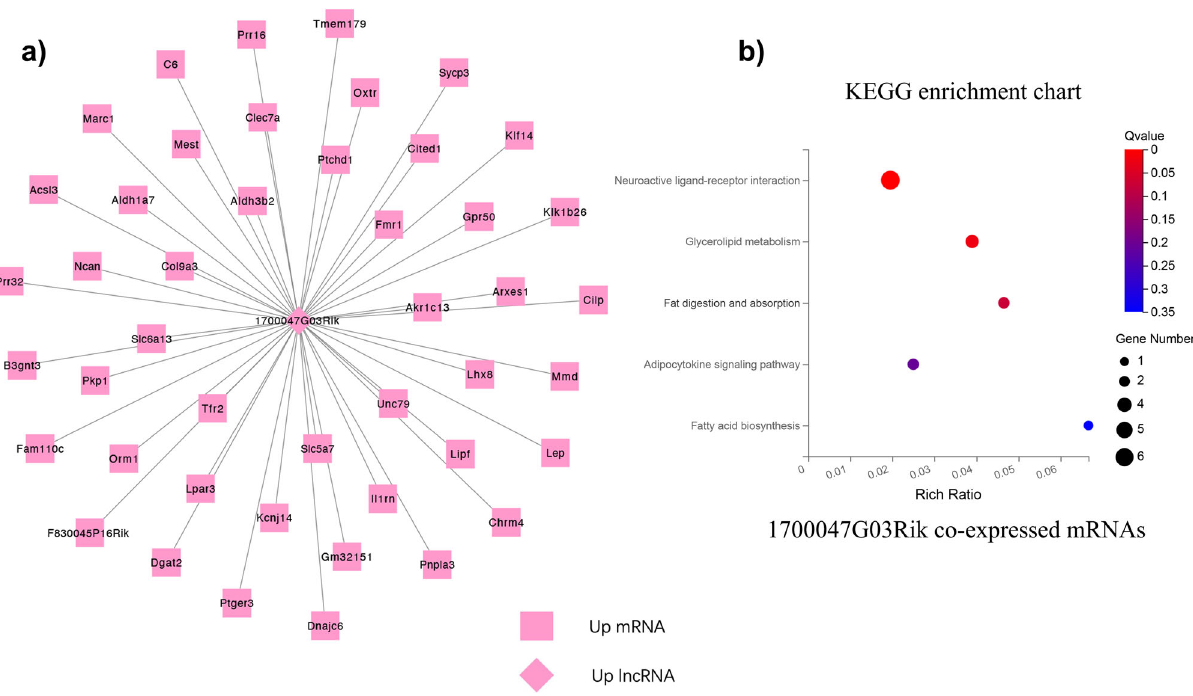
Fig. 8 Co-expression network analysis and functional prediction of lncRNA 1700047G03Rik. a The lncRNA 1700047G03Rik and 45 mRNAs were constructed in a co ‐ expression network with a PCC > 0.95. b The top signi fi cant pathway terms of dysregulated genes associated with 1700047G03Rik were displayed according to KEGG analysis. Note: PCC: Pearson correlation coef fi